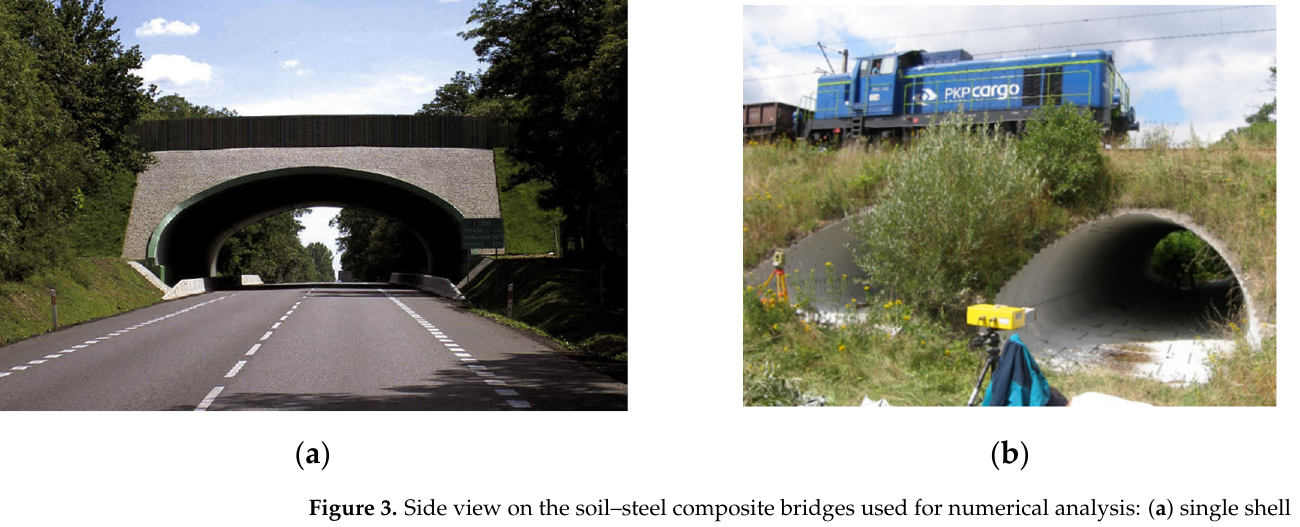
Figure 3. Side view on the soil–steel composite bridges used for numerical analysis: ( a ) single shell located in Trzebaw (Poland), and ( b ) double shell located in Krosnowice (Poland). The structure of the shell made of CSPs was covered with layers of soil (about 0.2 m